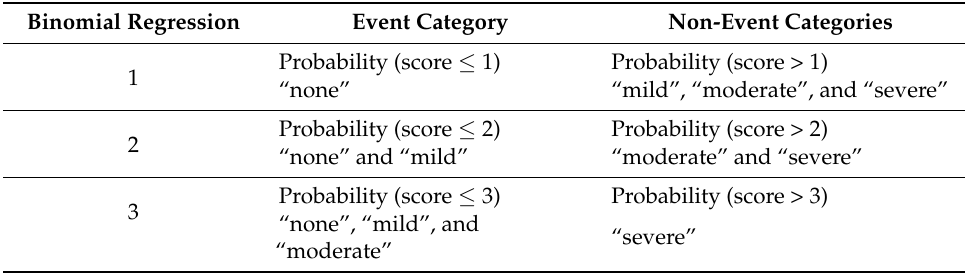
Table 3. An ordinal dependent variable (DV) with four levels giving three cumulative probabilities and consequently